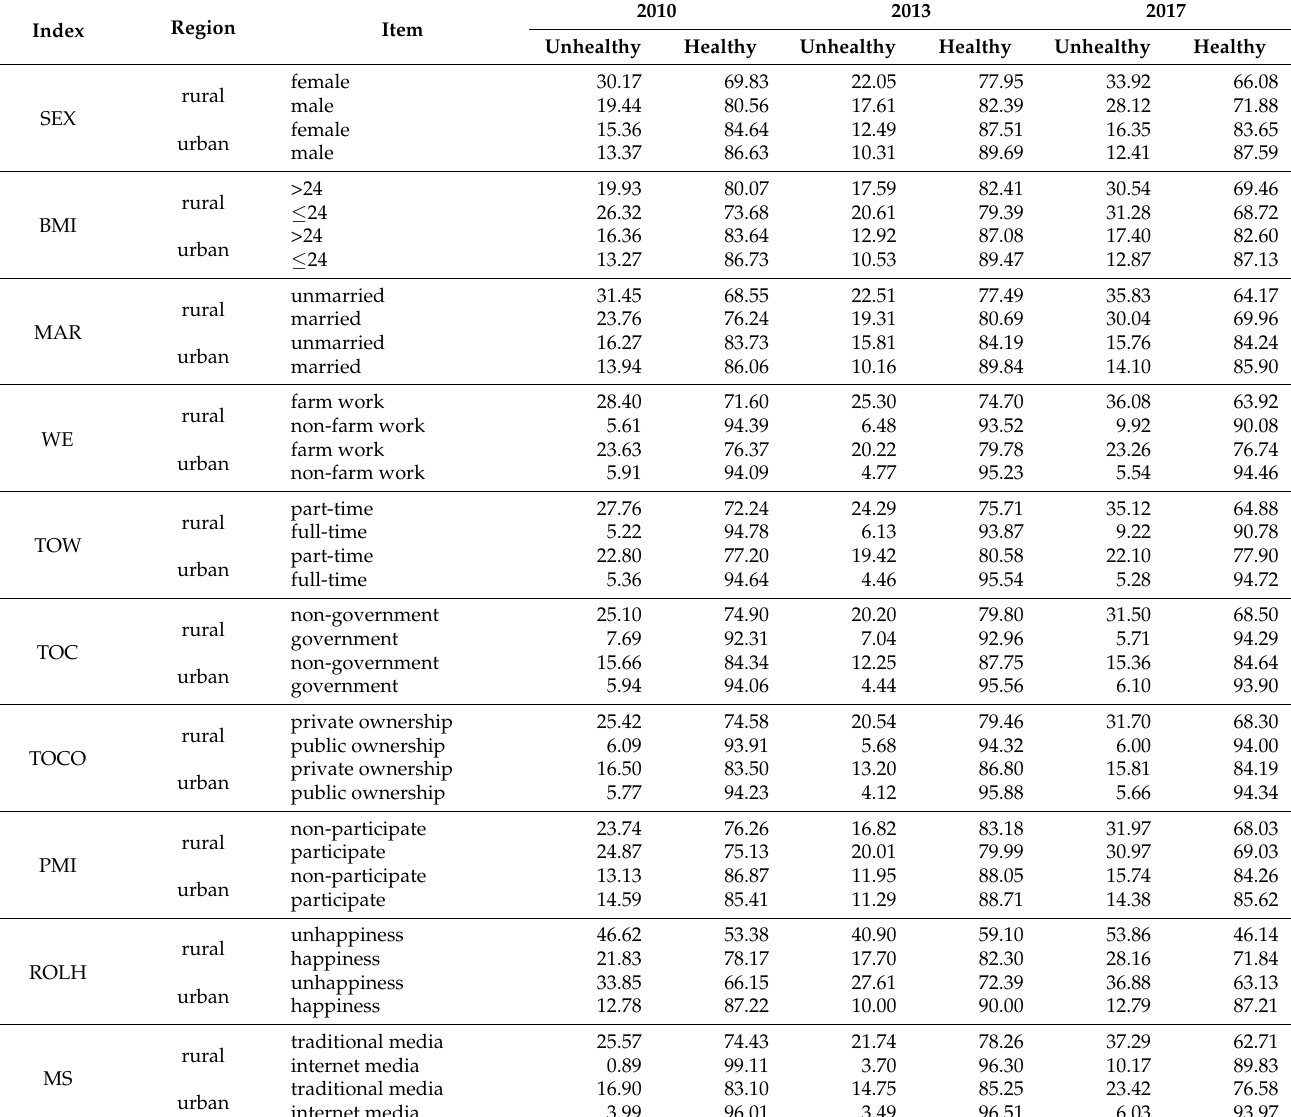
Table 4. Cross analysis of health status and personal attributes considering urban and rural